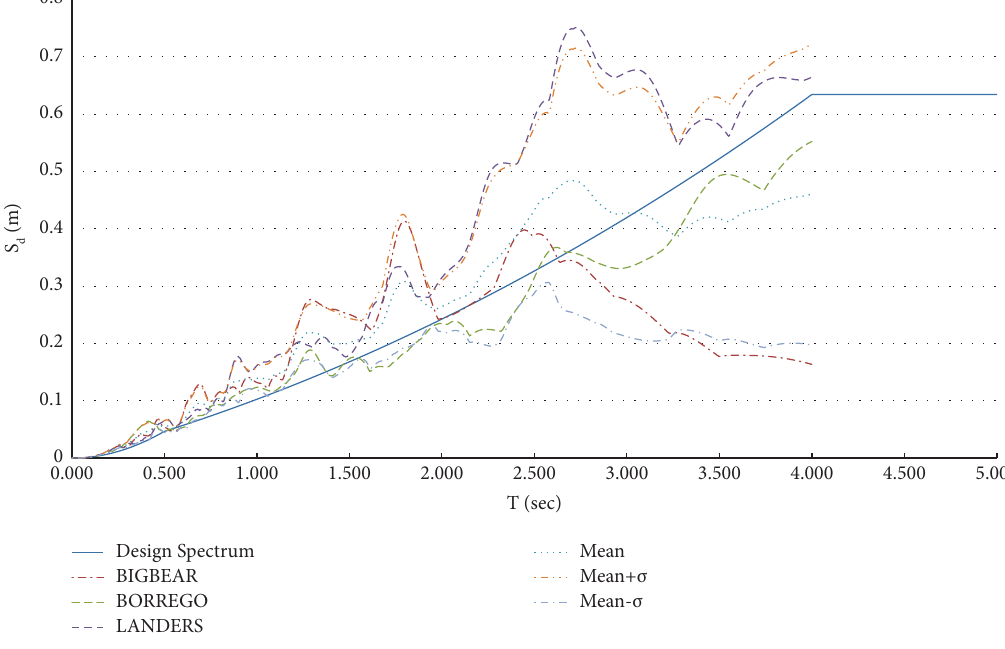
Figure 6: Scaled earthquakes displacement response spectrum.